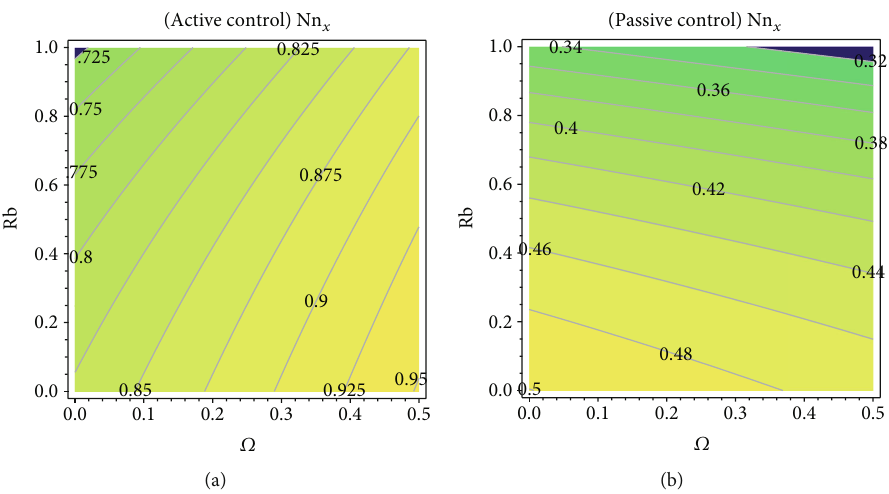
Figure 10: The e ff ect of motile microorganism ’ s density number for combined parameters Rband Ω